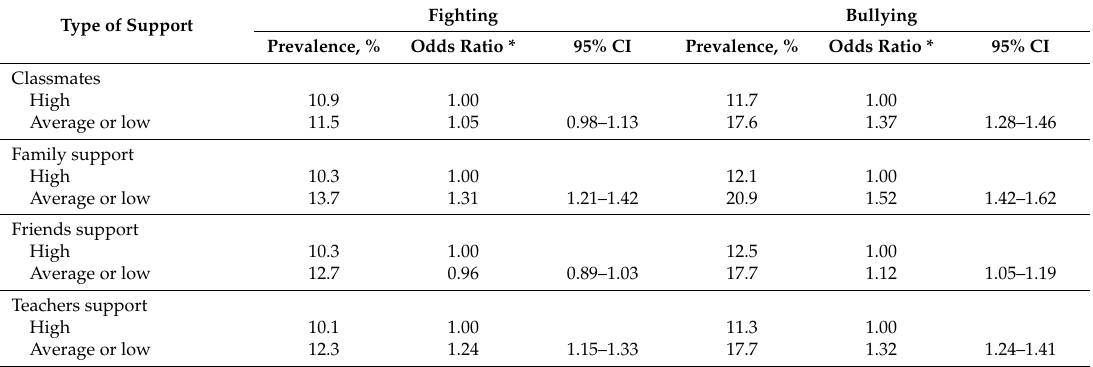
Table 8. Different types of social support as protective factors against fighting and bullying.